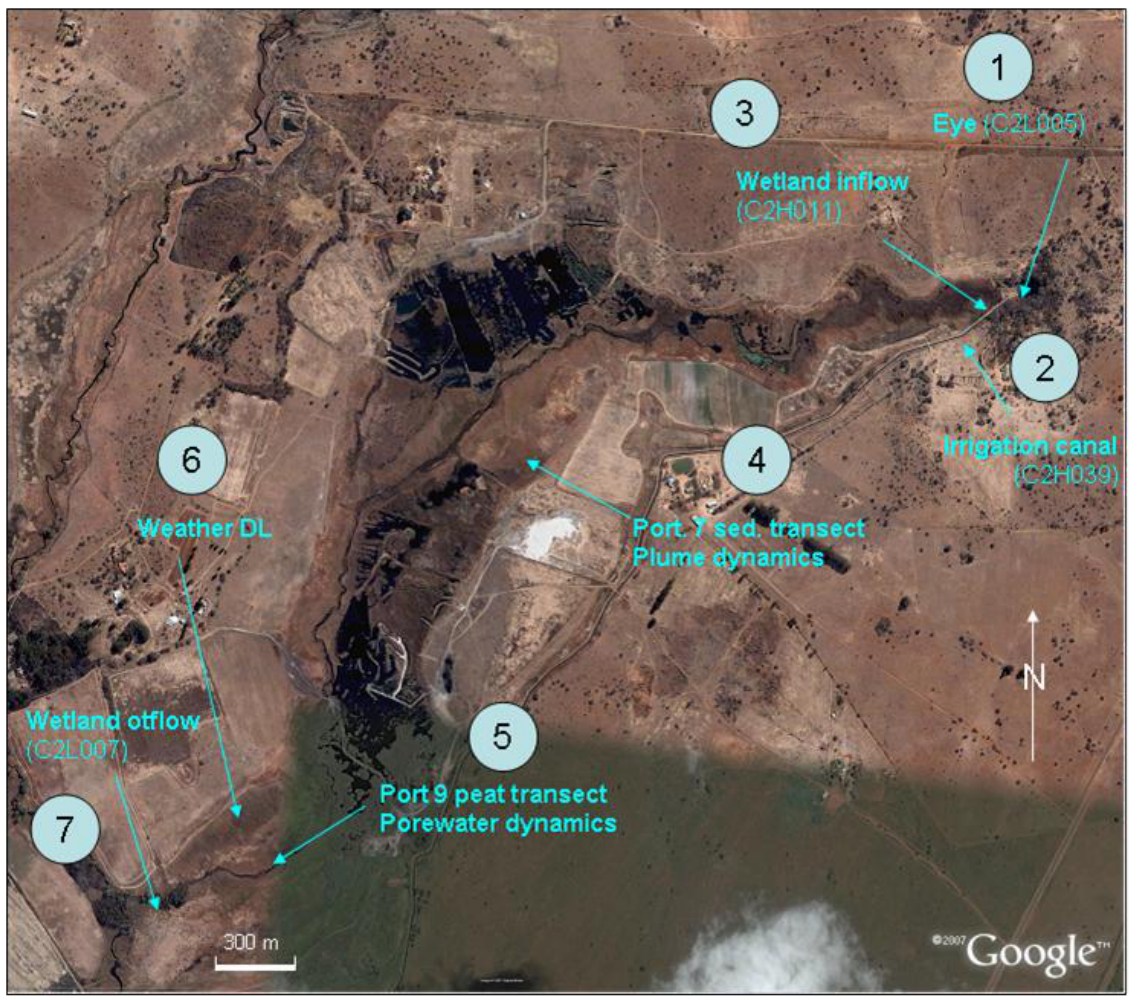
Figure 12. Location of automatic measuring stations installed in the Gerhard Minnebron Wetland (DL-data